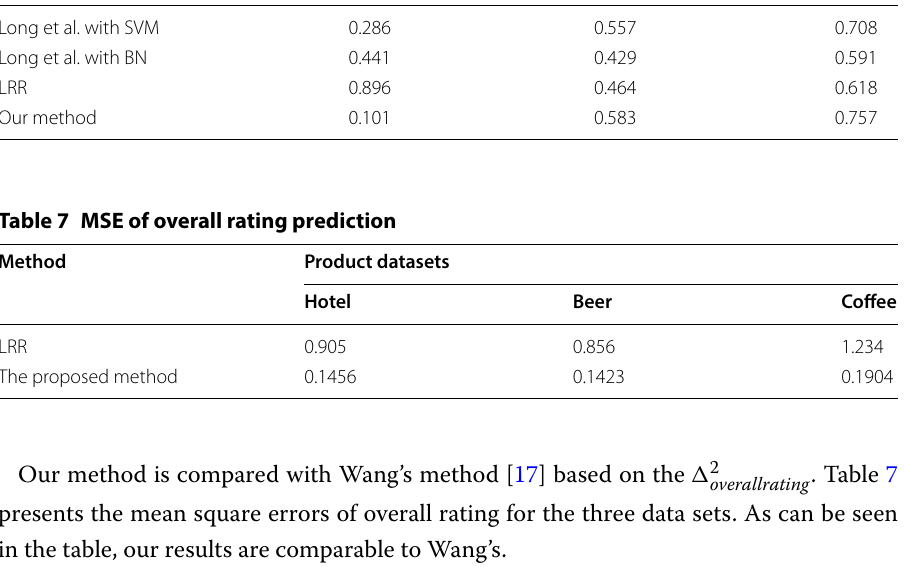
Table 6 Comparison with other models for referring aspect ratings Method